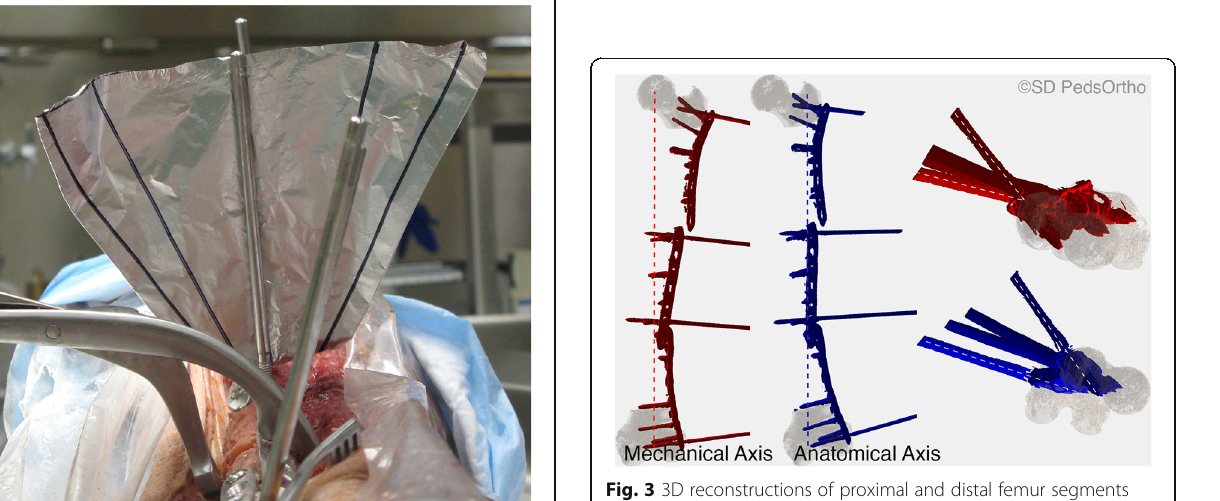
Fig. 3 3D reconstructions of proximal and distal femur segments from one of the specimens with plate and screw reconstructions incorporated (red shows mechanical axis alignment from the center of the femoral head to a mid-point between the femoral condyles, blue shows anatomical axis along the femoral shaft length). Dashed lines on axial views on the right side of the figure show Pin Angle, automatically calculated in the mechanical and the anatomical